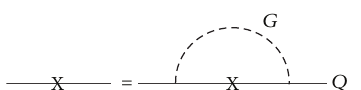
Figure 1: Gap equation for generating heavy quark mass from Goldstone boson